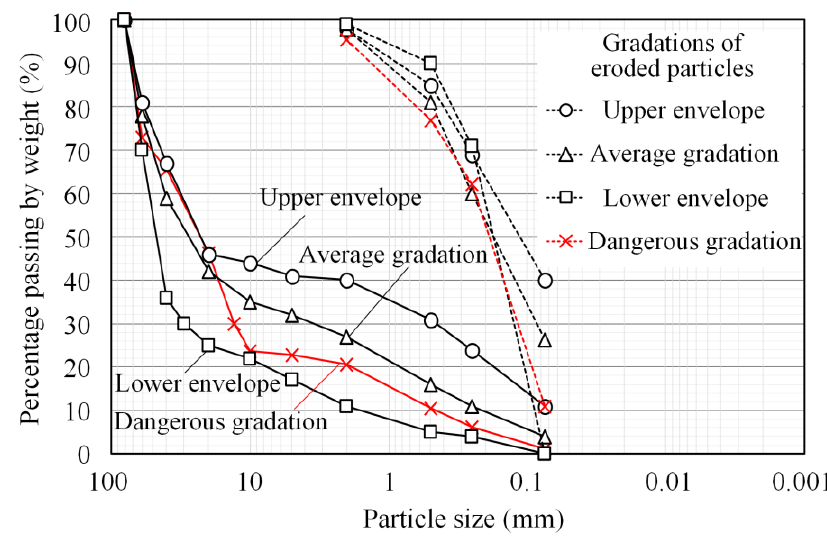
Figure 2. Gradations of stratum ① and eroded particles.